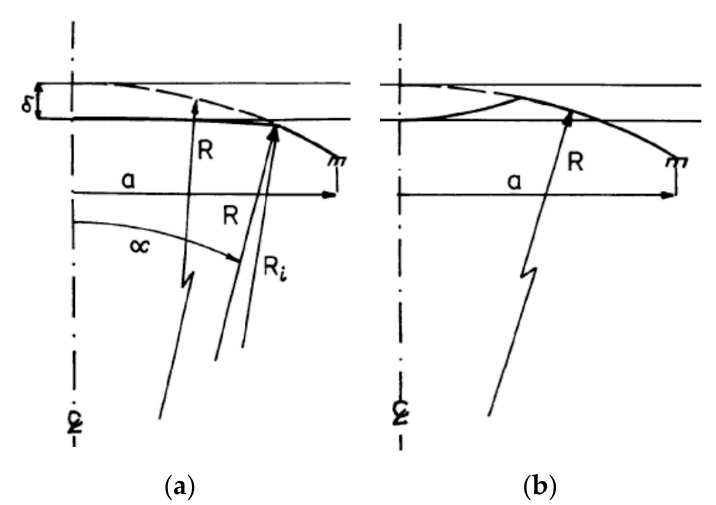
Figure 13. Geometrical parameters illustrating the imperfect axi-symmetric spherical shallow shells: ( a ) the convex imperfection in the form of an increased radius polar radius, ( b ) the concave imperfection characterized by the cosine function.